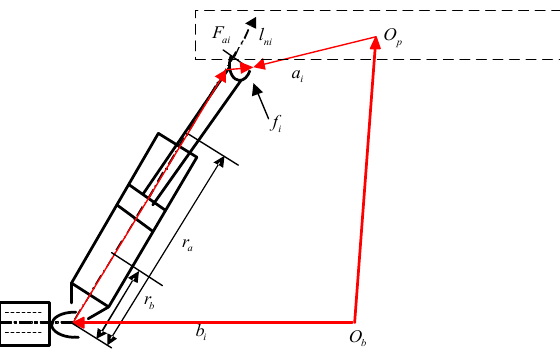
where the kinetic energy of the cylinder case,  is the kinetic energy of the piston ) 22 rod, is the rotational kinetic energy of the cylinder case ,1, ,2, m is the mass of the cylinder case, m is the mass of the piston rod, and the piston rod, t g r is the mass center position of the cylinder case relative to the lower gimbal joint, r is b a l is the the mass center position of the piston rod relative to the lower gimbal joint, m i is the moment of inertia of the cyl- piston position relative to the lower gimbal joint, t θ  is the angular velocity of the i is the moment of inertia of the piston rod, inder case, r i θ  and θ  are the angular velocities of cylinder case around the lower gimbal joint, ,2, g i ,1, g i the piston rod around the flexible axis 2 and the flexible axis 1. The potential energy of the i-th leg can be expressed as: